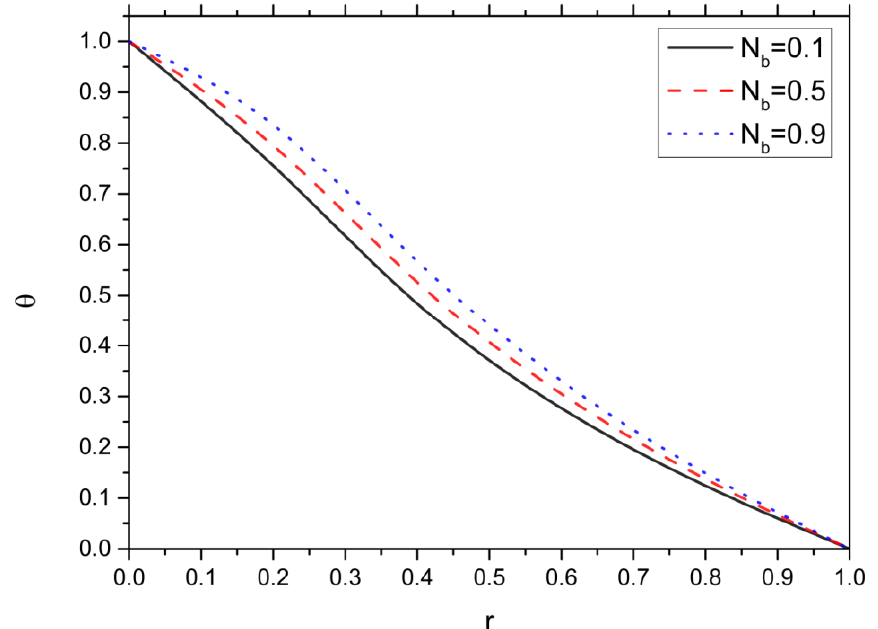
Fig. 4(a). Temperature (  ) contrary to r with